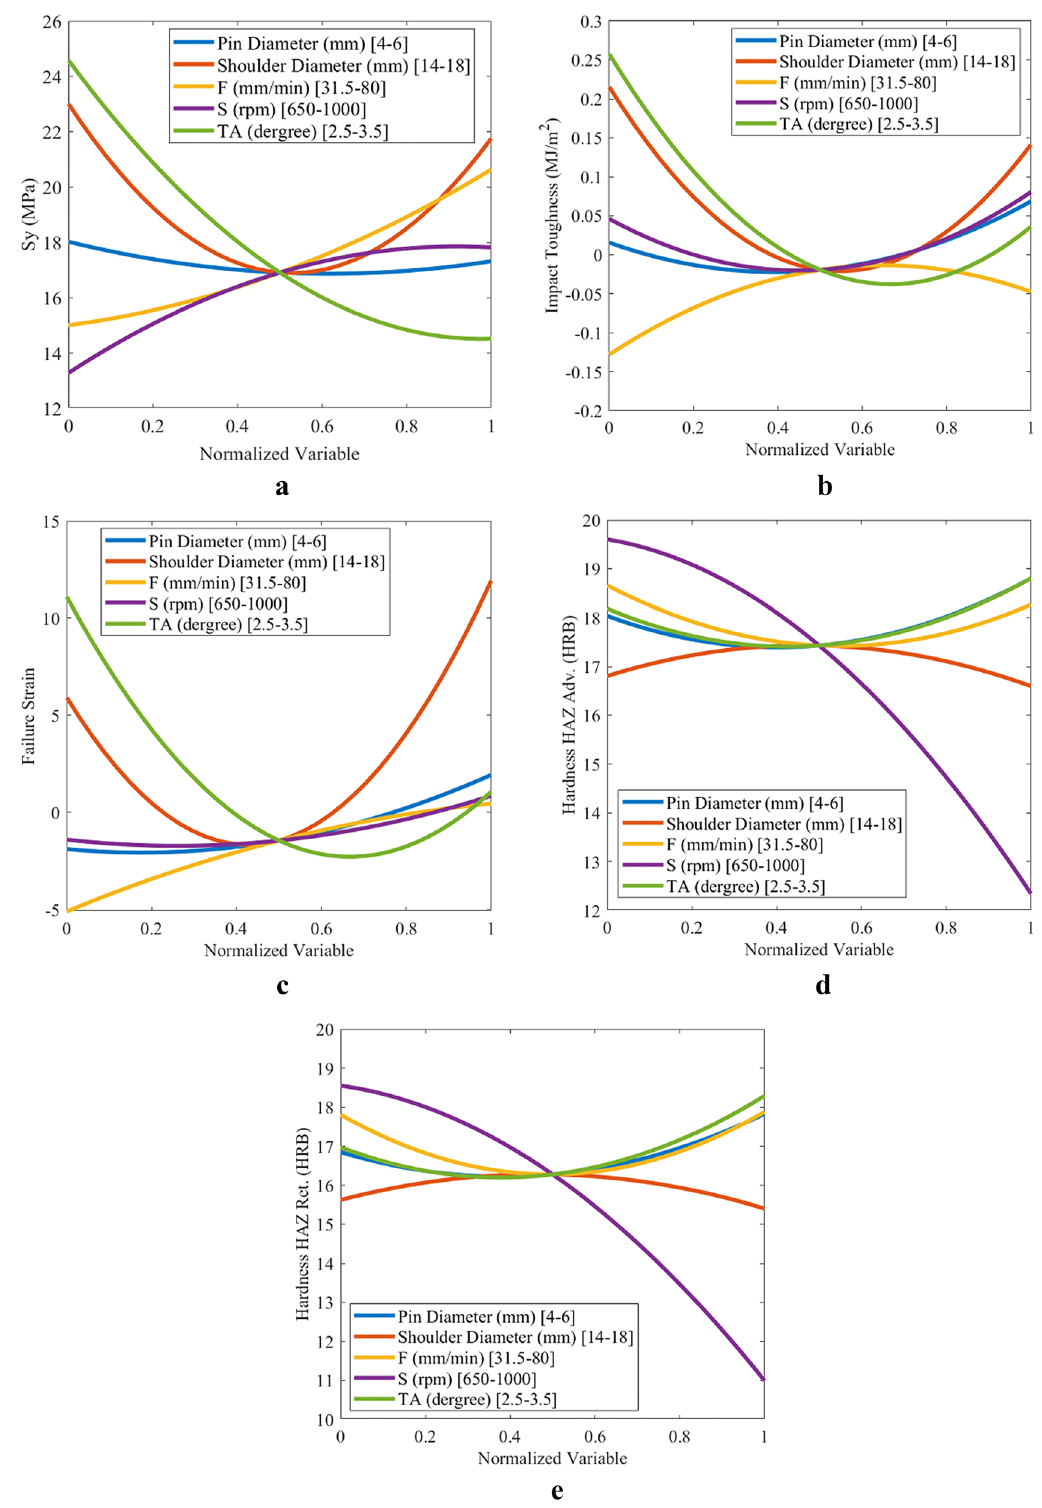
Figure 9. Variations in conical pin objective functions for ( a ) yield strength, ( b ) impact toughness, ( c ) failure strain, ( d ) hardness on HAZ adv., and ( e ) hardness on HAZ